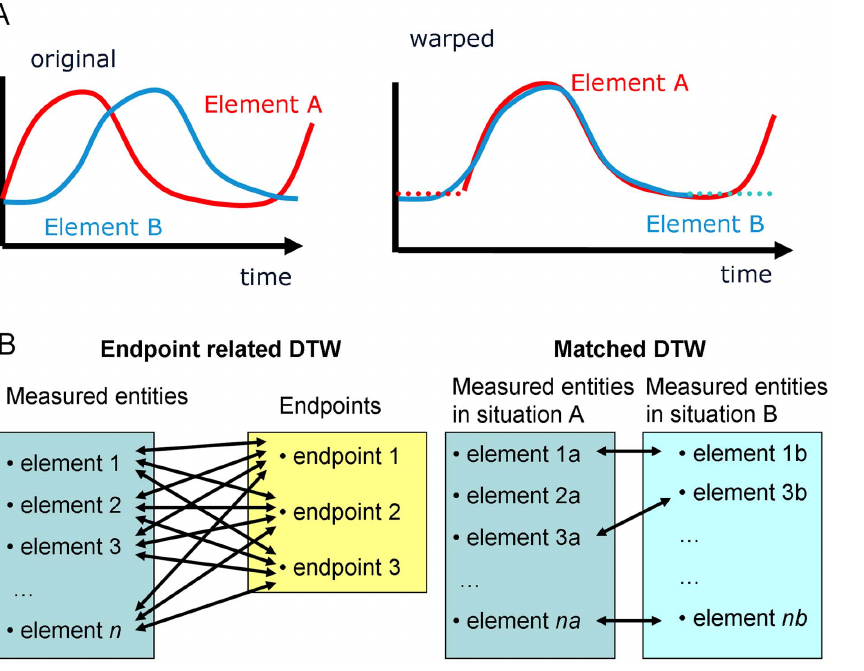
Figure 1. Dynamic time warping. Panel A shows how time series can be aligned using dynamic time warping from the original (left) to the warped (right). Panel B shows the two varieties of DTW provided by DTW4Omics, showing the comparistons which are considered in case.